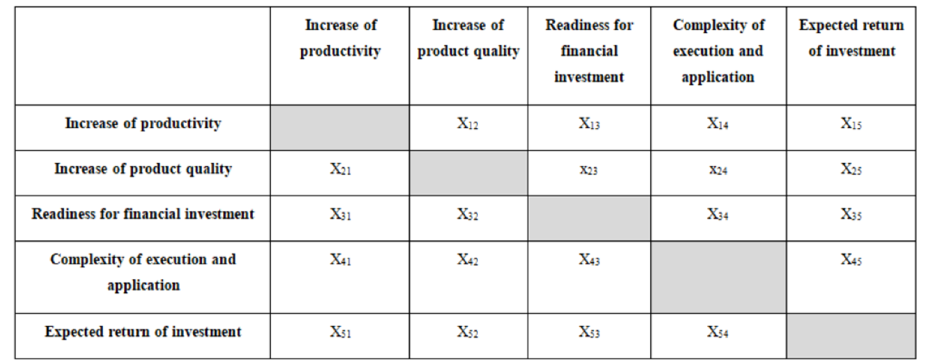
Figure 2. Priority matrix of the goals.